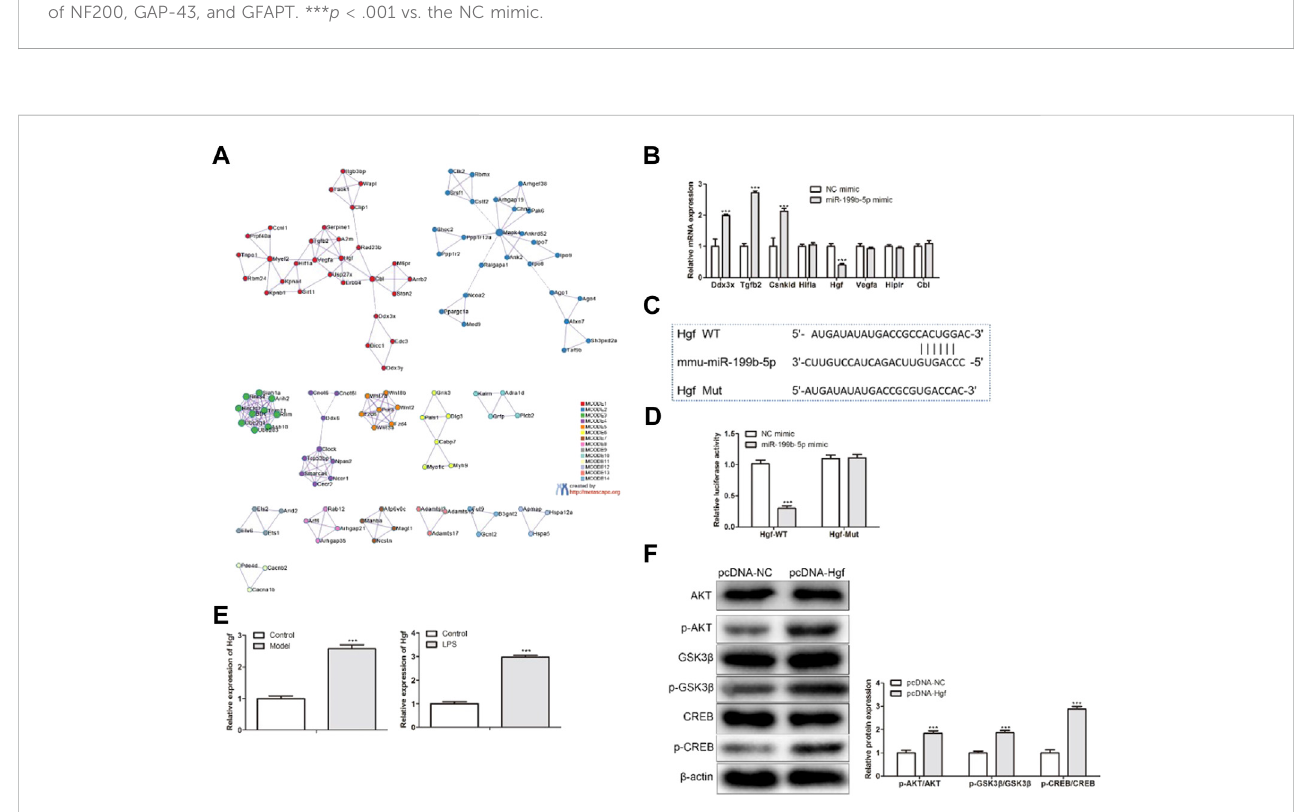
FIGURE 6 Hgf was targeted by miR-199b-5p and Hgf activated PI3K signaling pathway in vitro . (A) The TargetScan and Metasacpe databases predicted the target gene of miR-199b-5p. (B) RT-qPCR showed the expression of eight potential targets. (C) The predicted binding sequences of miR-199b-5p and Hgf by TargetScan. (D) Therelativeluciferaseactivity.*** p < .001vs.theNCmimic. (E) RT-qPCRshowedHgfexpressioninboththeSCImicemodelandLPS-treated BMDM. *** p < .001 vs. the control group. (F) Western blot assay detected PI3K signaling pathway-related protein expression. The